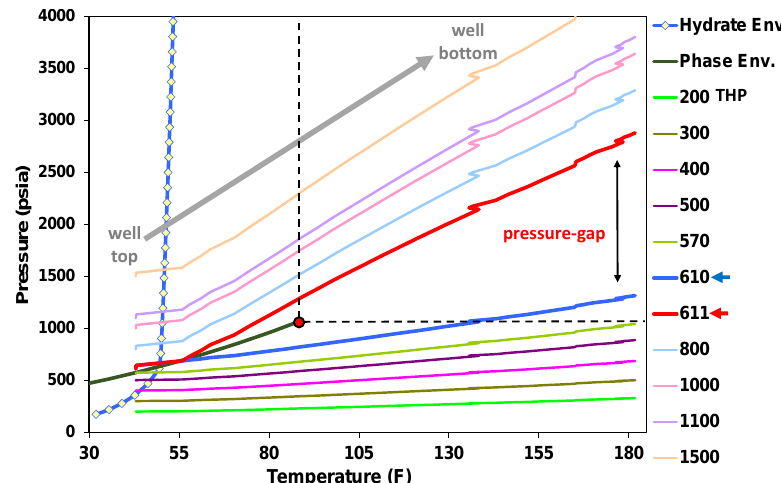
Figure 6. CO 2 pressure and temperature within the wellbore for different THP scenarios and superimposed on the CO 2 phase envelope. The hydrate-formation envelope is also shown for reference. There are PT situations that fall within the hydrate-formation region.